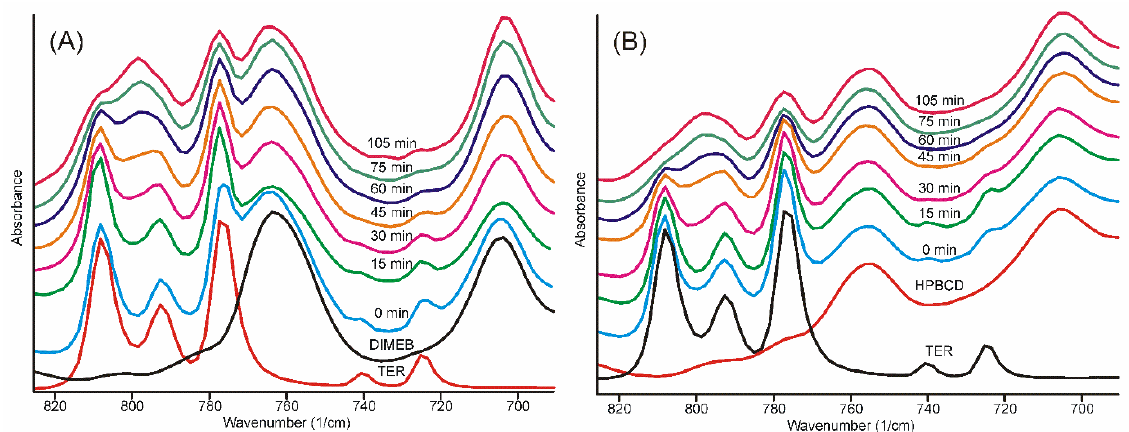
Figure 6. FTIR spectra of samples. The evolution of the bands in the out-of-plane deformation vibrations of the aromatic rings as the grinding time increases. The characteristic bands of TER ( A ) DIMEB and ( B ) HPBCD practically disappeared between 75 and 105 min.